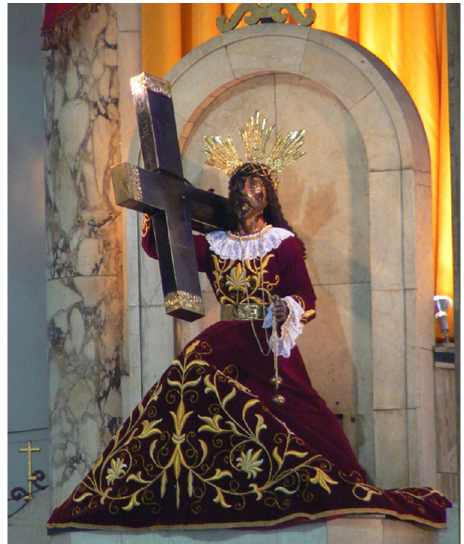
Figure 1. Image of the Black Christ Nazarene of Quiapo, Nuestro Padre Jesus Nazareno or NPJN (photograph by the author).